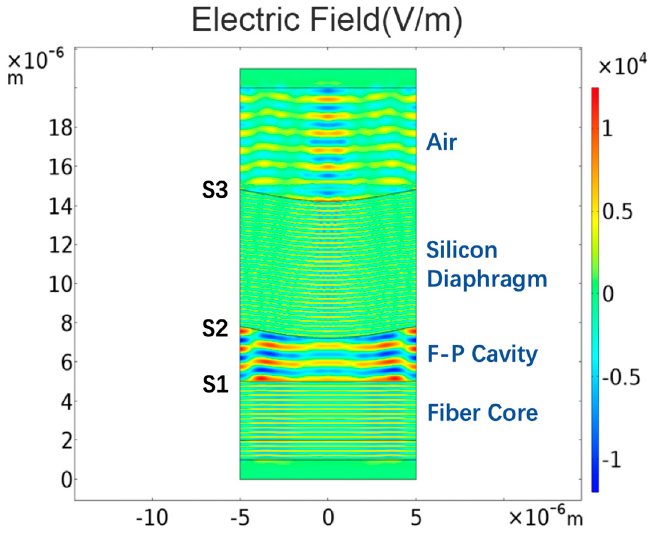
Figure 4. Simulation of distribution of electric ‐ field intensity.